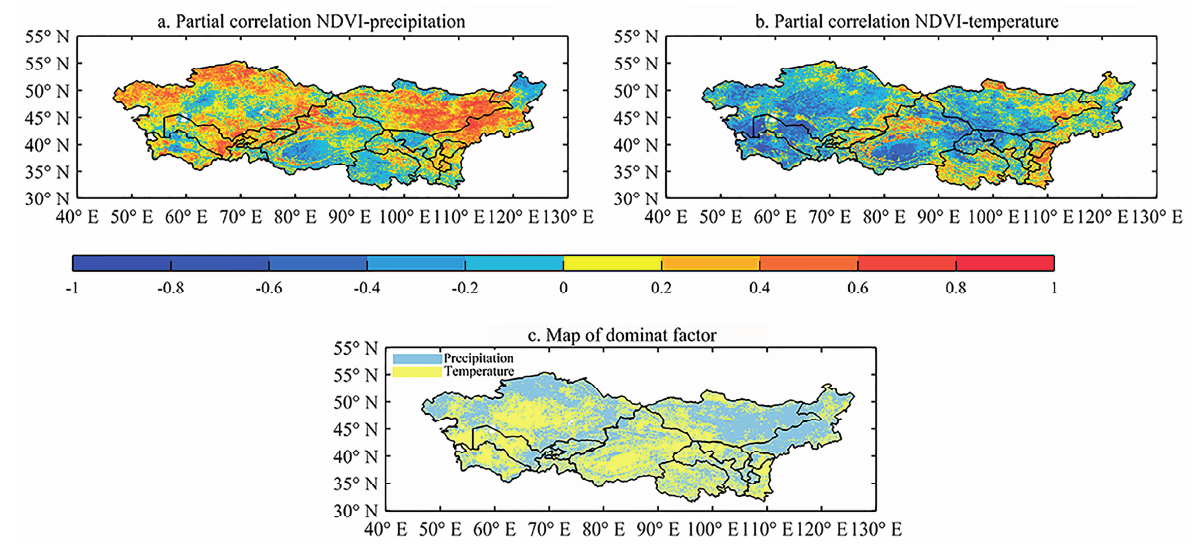
Figure 5. Partial correlation between NDVI and temperature ( a ) and between NDVI and precipitation ( b ) during the growing season and dominant control on the NDVI ( c